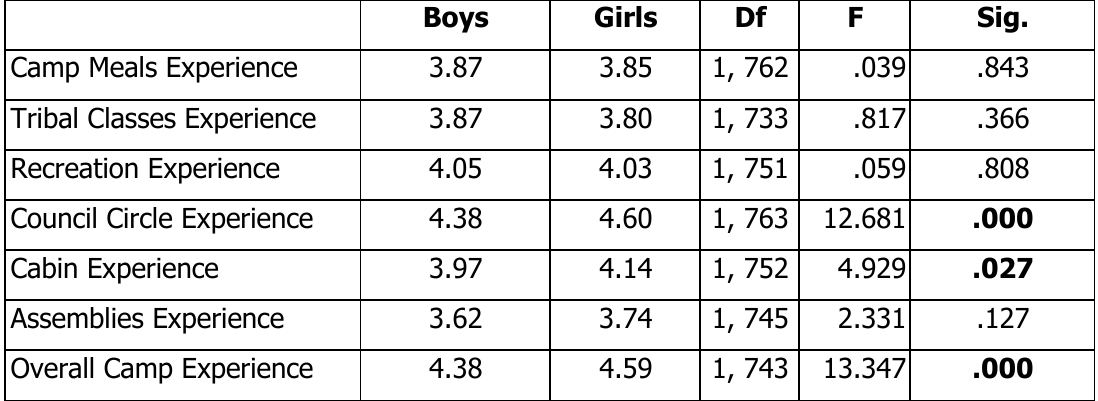
Comparing Camp Experience (Activity) Items for Boys &